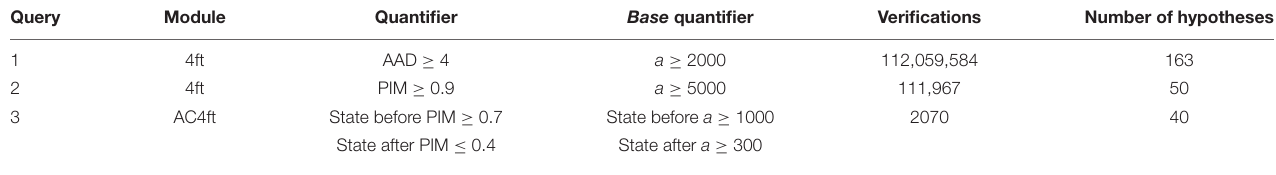
TABLE 3 | Technical information of